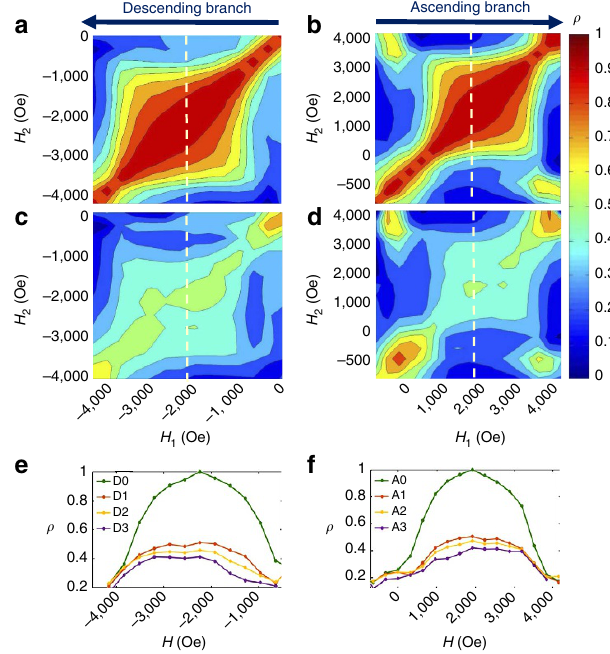
Figure 3 | Correlations maps and slices measured at 20K after FC under H FC ¼ 3,200Oe. ( a , b ) Correlation maps r ( H 1 , H 2 ) measured within the same cycle on the descending and ascending branches, respectively. ( c , d ) Correlation maps r ( H 1 , H 2 ) measured at one cycle separation. ( e , f ) Vertical slices at H 1 ¼ H* (along the dashed line). These graphs show slices through successive correlation maps, using the notation A0, A1 y D0, D1 and so on. In this notation, the letter A stands for the ascending branch, the letter D stands for the descending branch and the index corresponds to the number of cycles separating the two correlated but we find here that diagonally slicing subsequent maps also lead to r B 100%. This suggests that during the magnetization process, The loss of MDM occurs similarly on the ascending and through the maps clearly show the drastic drop in r , from 100% to B 50%, after one cycle. During subsequent cycles, r continues to gradually drop, from B 50% down to 40% after three cycles.